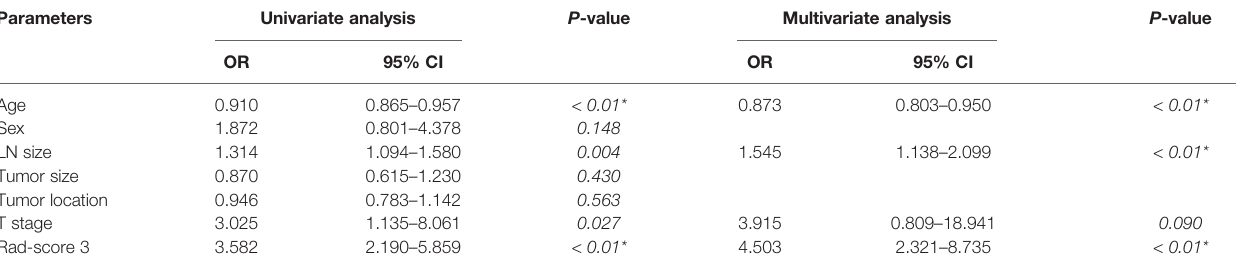
TABLE 3 | Univariate and multivariate logistic regression analysis of the clinical parameters and rad-score 3.